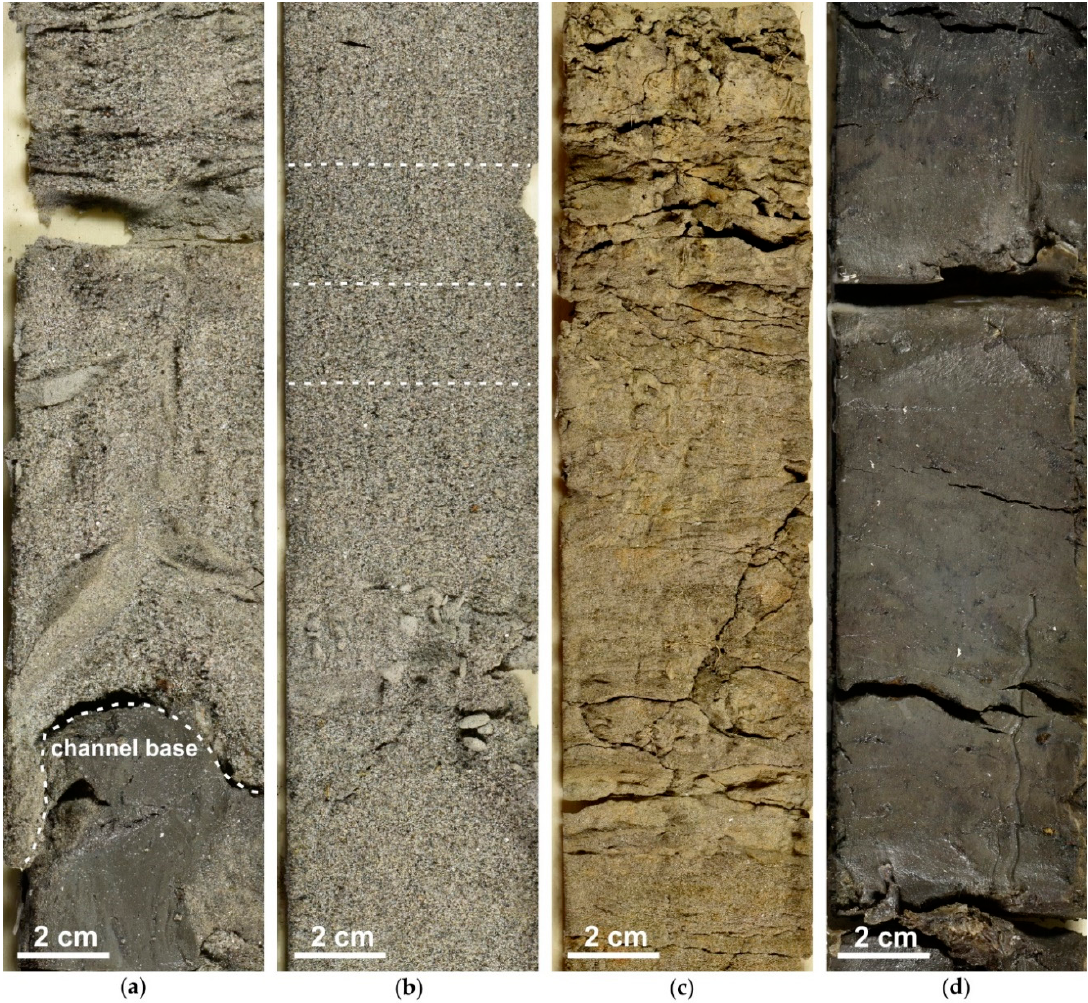
Figure 8. Cored deposits: ( a ) massive medium sand with pebble-sized mudclasts forming the channel lag; ( b ) fine to medium sands from the lower point bar; ( c ) fine to very fine sands, with cross lamination and mud layers from the upper point bar; and ( d ) massive overbank mud with moderate organic content and horizontal bedding.